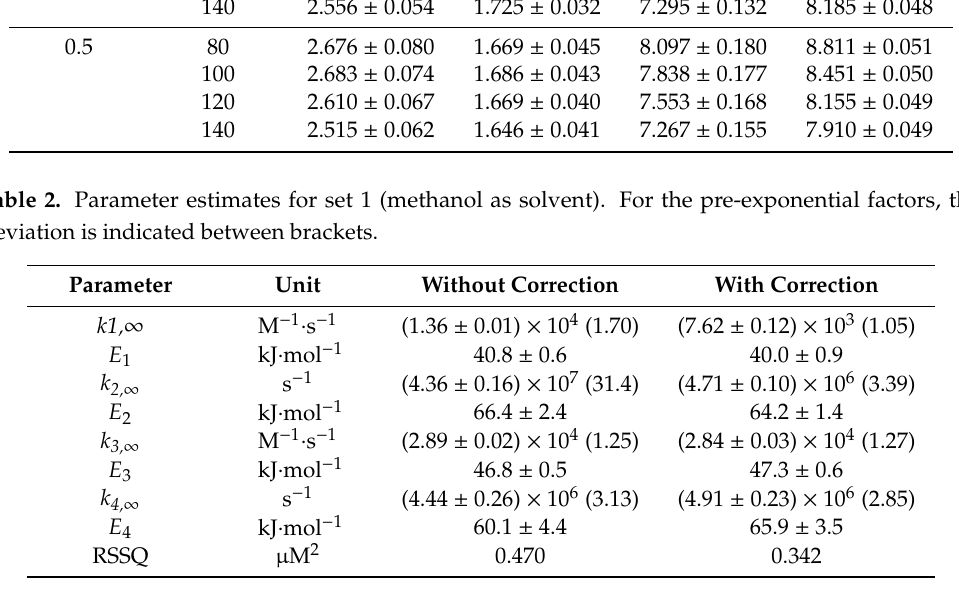
Table 3. Parameter estimates for set 2 (ethanol as solvent). For the pre-exponential factors, the deviation is indicated between